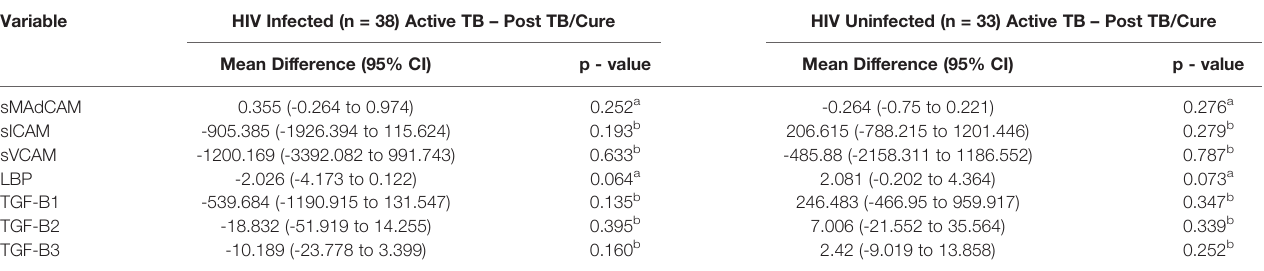
TABLE 2 | Changes in measured analytes in response to TB treatment in HIV infected (n = 38) and HIV uninfected (n = 33) IMPRESS study participants. HIV Infected (n = 38) Active TB – Post